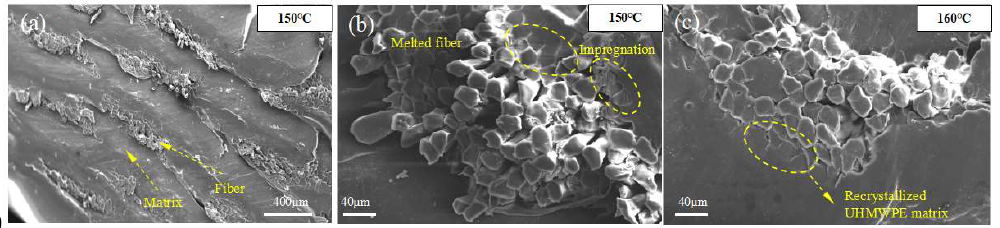
Figure 7. SEM images of the CFSRC’s surface cut perpendicular to the fibers’ axis printed at ( a , b ) 150 °C and ( c ) 160 °C.